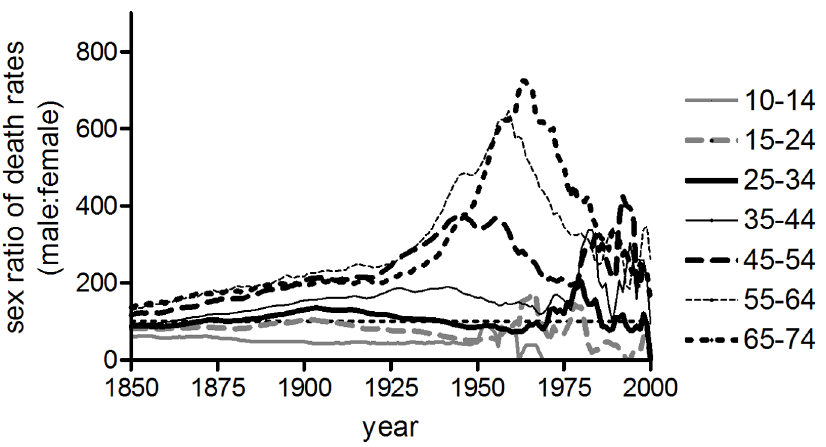
Figure 10. Age-specific sex ratios of respiratory tuberculosis mortality by period of death, England and Wales.